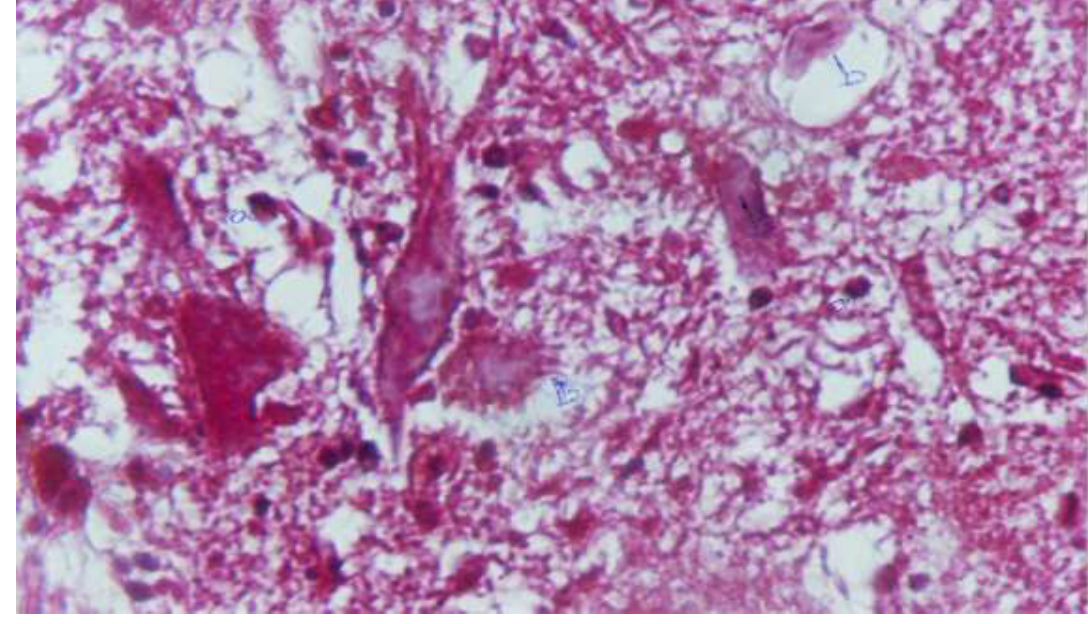
Figure ( 3 ):Brain of Mice , 2 nd group see:(a) Monouclear cell in spinal cord and ( b ) Necrosis ( X 40 H& E stain